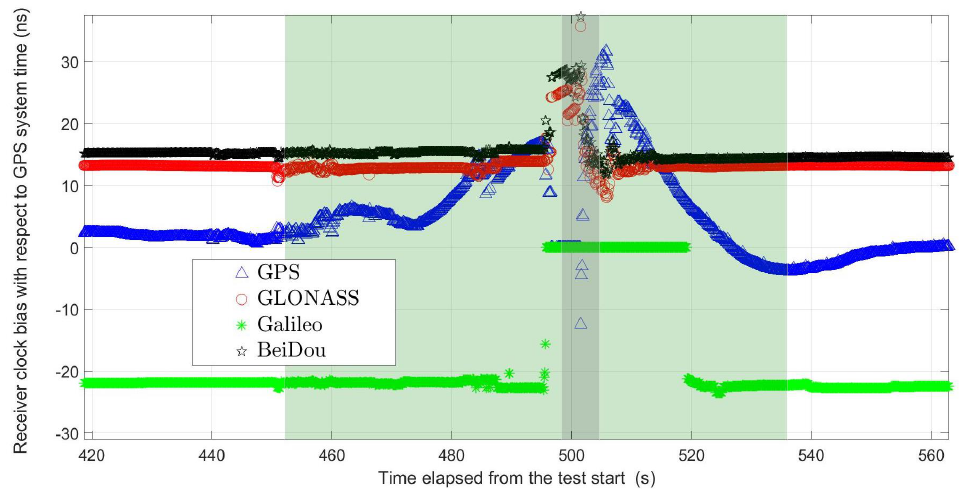
Figure 9. Clock biases for Leica GS18 during drive No. 2. The lighter shaded area represents the time interval of that drive, while the darker shaded area represents the interval when the antenna was closest to the jammer (own